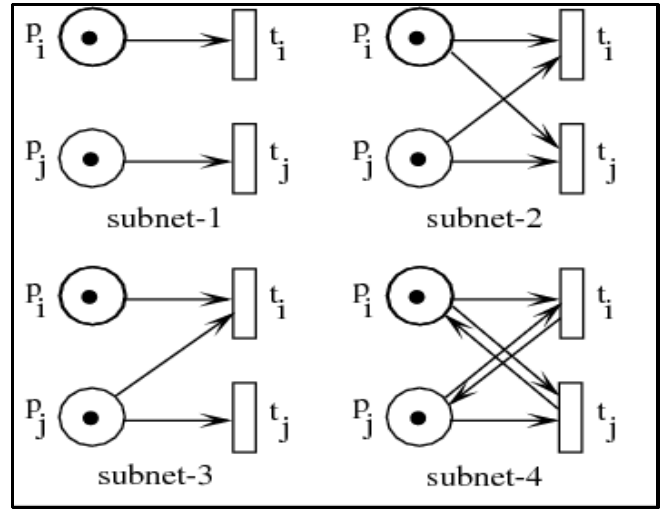
Figure 4. Forbidden